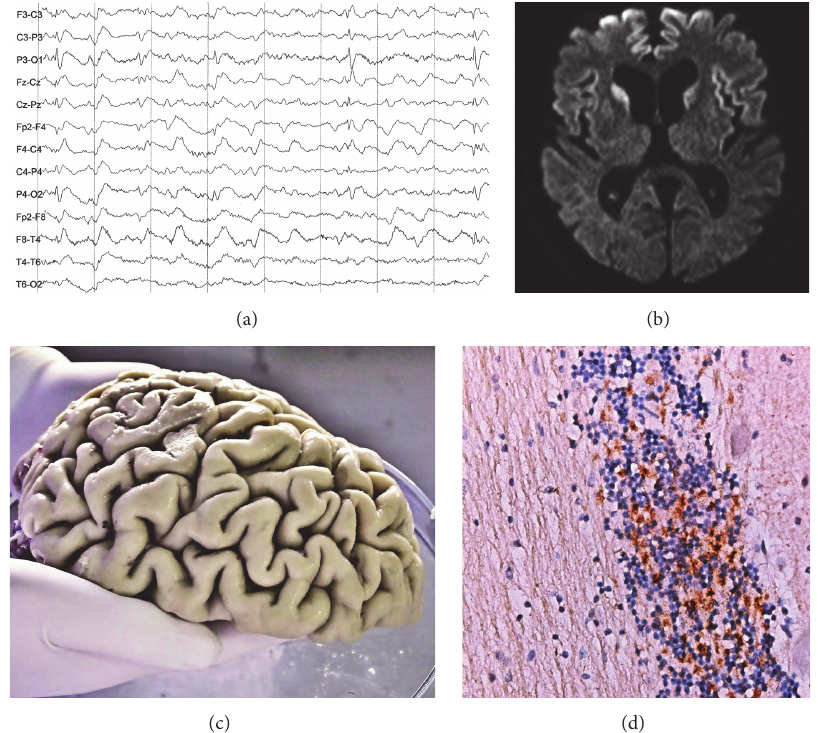
Figure 1: Antemortem and postmortem findings in an index case. (a) An EEG with pseudoperiodic generalized triphasic slow waves on the 23rd day of the disease. (b) Axial brain DWI shows hyperintense areas in bilateral caudate nuclei, bilateral frontal, and left insular cortex. (c) Macroscopic view of the left frontal lobe atrophy. (d) Immunohistochemical confirmation of prion protein with 6H4 monoclonal antibodies (granular layer of the cerebellar cortex, 400x